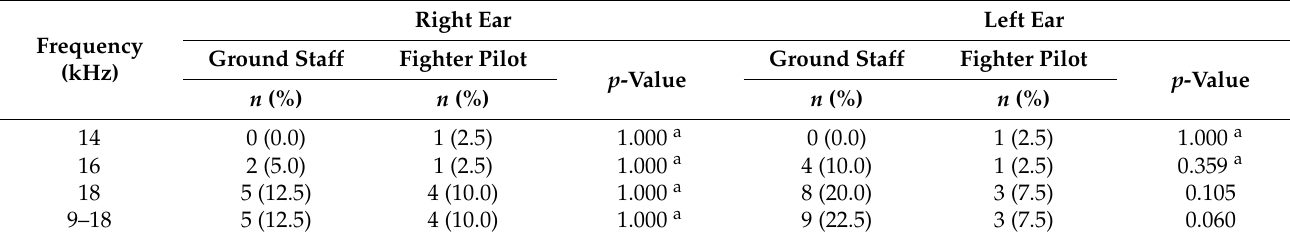
Table 3. Comparison of the rates of output levels beyond the equipment maximum in measuring hearing thresholds using EHFPTA in the ground staff and fighter pilot groups.